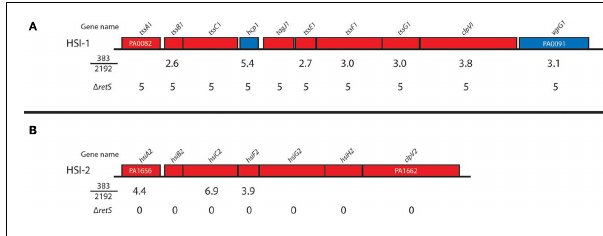
FIGURE 2 |Type 6 secretion operons and their expression in strain 383 and 2192. The relative expression of the type 6 secretion system (T6SS) genes are indicated for the comparisons of strain 383 to 2192 from Rao et al. (2008) and also the relative expression from a retS deletion mutant whereT6SS genes are uniformly upregulated (Goodman et al., 2004; Mougous et al., 2006;Ventre et al., 2006). Genes are named and colored according to Pseudomonas Genome Database. (A,B) Indicates the P. aeruginosa HSI-I and HSI-II operons ofT6SS genes, respectively.